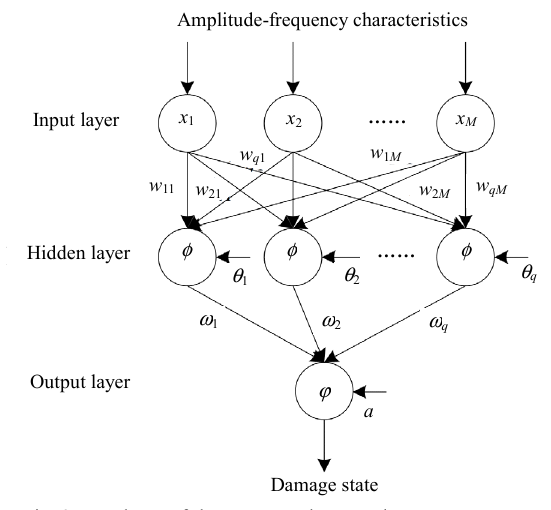
Fig. 7 Amplitude-frequency characteristics of signals detected by FBG1.